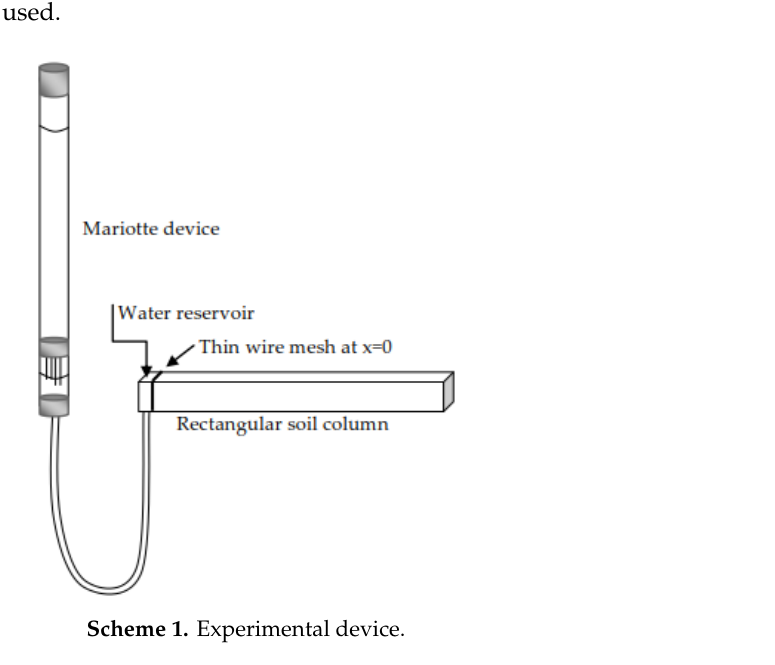
Table 1. The values of the soil characteristics θ 0 , θ in , ρ φ , and S , together with the values of the parameters λ i , p , and S c for each soil examined. The value of the parameter p was estimated from Equation (6). The value of sorptivity S was obtained directly from the experimental I ( t ) data (Equation (18)), while S c comes from Equation (14). RE denotes the absolute relative error between actual S and estimated S c values for each soil examined.